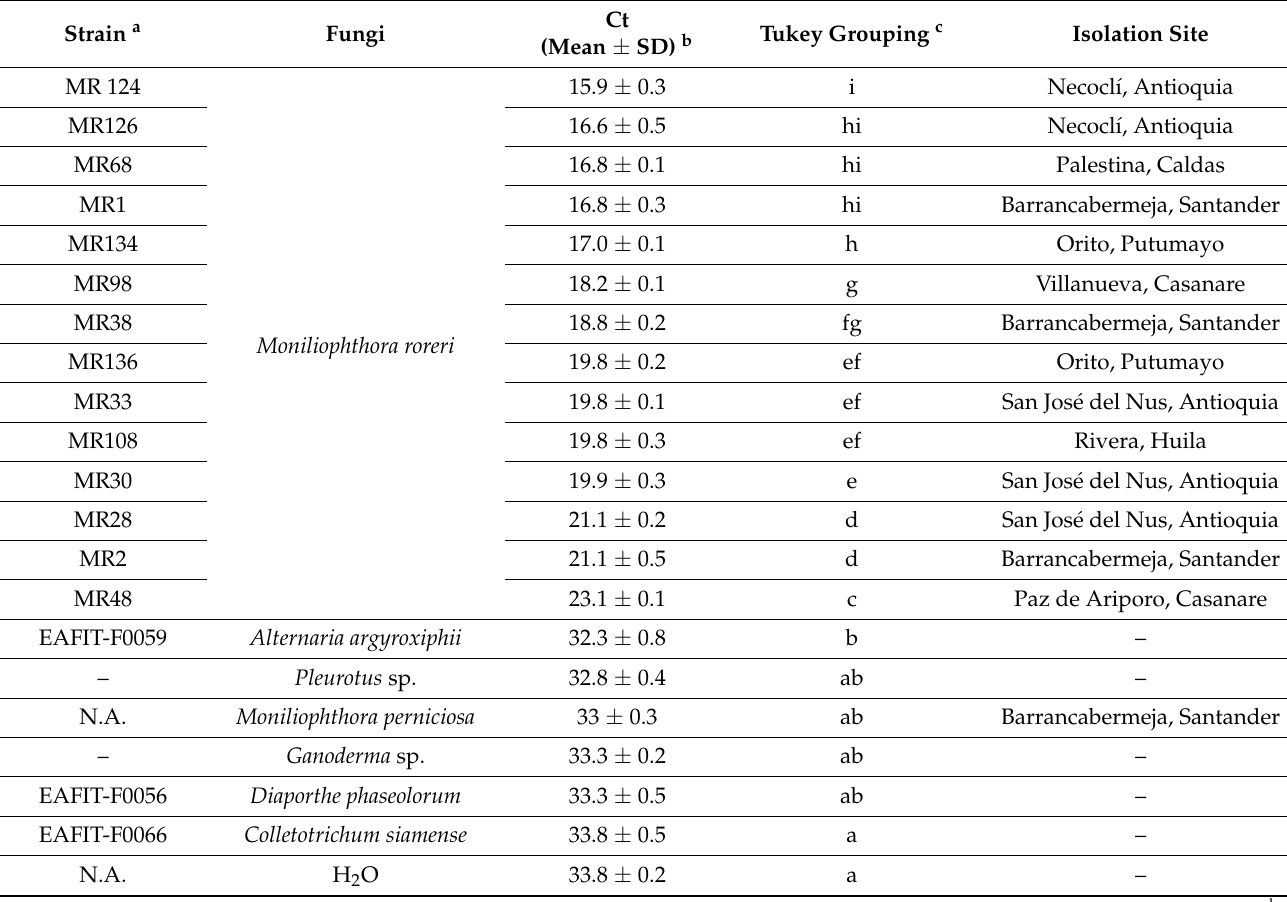
Table 1. qPCR results for the evaluations assessing the specificity of the qPCR, including Monilioph- thora roreri strains originated from several cacao regions in Colombia and other